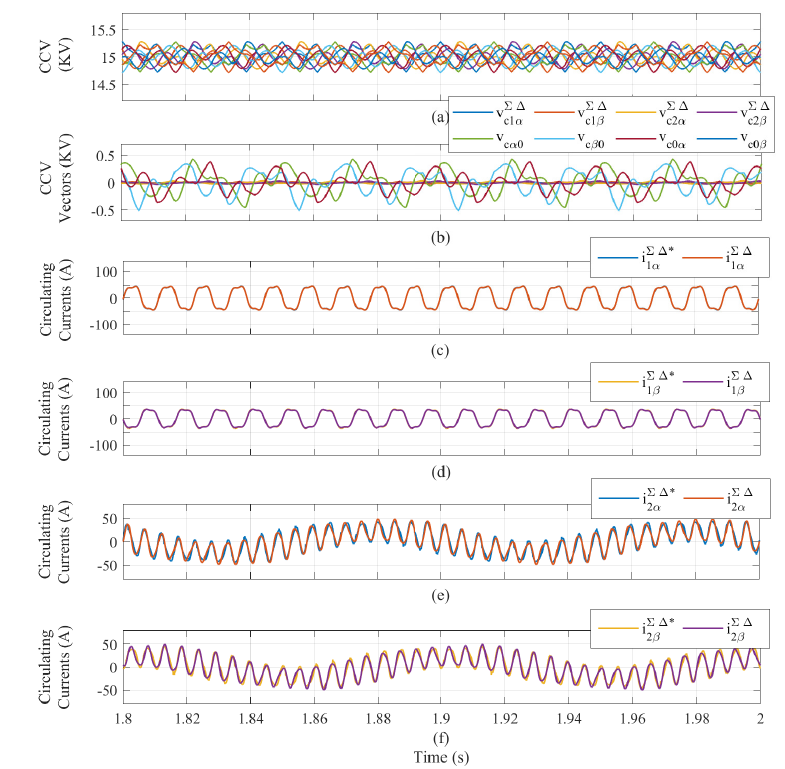
Figure 11. Test 2 results using a multi-resonant controller. ( a ) CCVs. ( b ) CCV vectors in the Σ∆ double- αβ 0 frame. ( c – f ) Circulating current components in the Σ∆ double- αβ 0